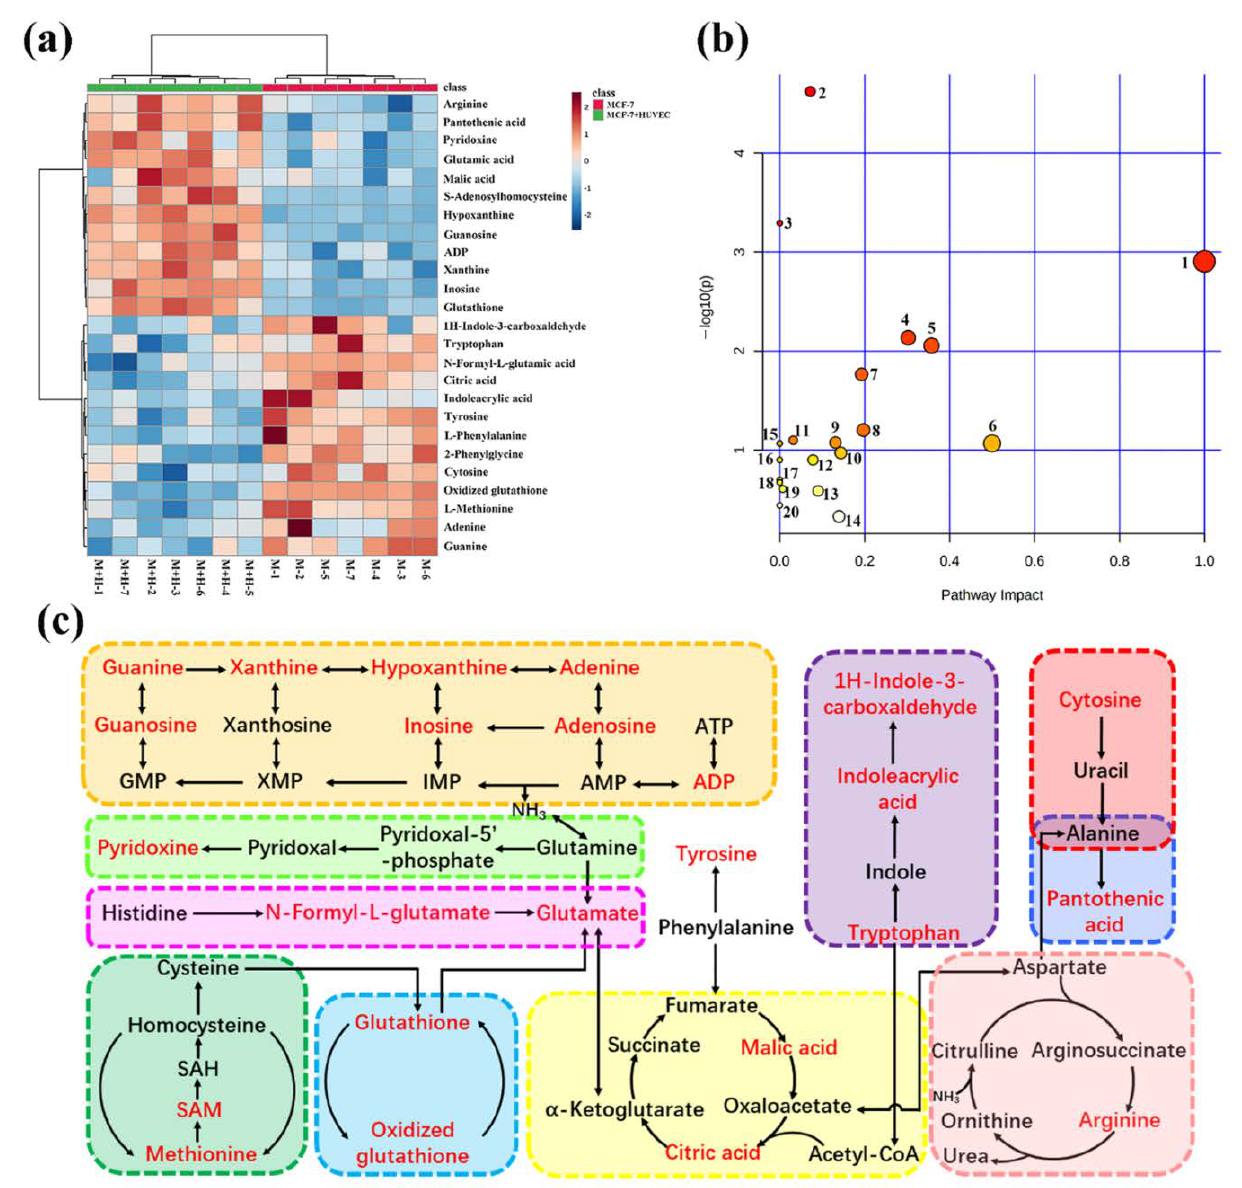
Figure 1. Heat map of single-culture and co-culture MCF-7 cells to visualize the abundance of biomarkers in each group. Each row represents a potential biomarker, each column represents a sample, and the change of color represents the change of biomarker content ( a ). Metabolic pathways affected by the co-culture model of MCF-7 cells. The meaning of numbers is as follows: 1. phenylalanine, tyrosine and tryptophan biosynthesis; 2. purine metabolism; 3. aminoacyl-tRNA biosynthesis; 4. glutathione metabolism; 5. phenylalanine metabolism; 6. D-glutamine and D-glutamate metabolism; 7. arginine biosynthesis; 8. alanine, aspartate and glutamate metabolism; 9. cysteine and methionine metabolism; 10. arginine and proline metabolism; 11. glyoxylate and dicarboxylate metabolism; 12. vitamin B6 metabolism; 13. citrate cycle (TCA cycle); 14. tyrosine metabolism; 15. nitrogen metabolism; 16. ubiquinone and other terpenoid–quinone biosynthesis; 17. butanoate metabolism; 18. histidine metabolism; 19. pantothenate and CoA biosynthesis; 20. porphyrin and chlorophyll metabolism ( b ). Correlation networks of potential biomarkers. The red-marked metabolites were regarded as the potential metabolites ( c ).